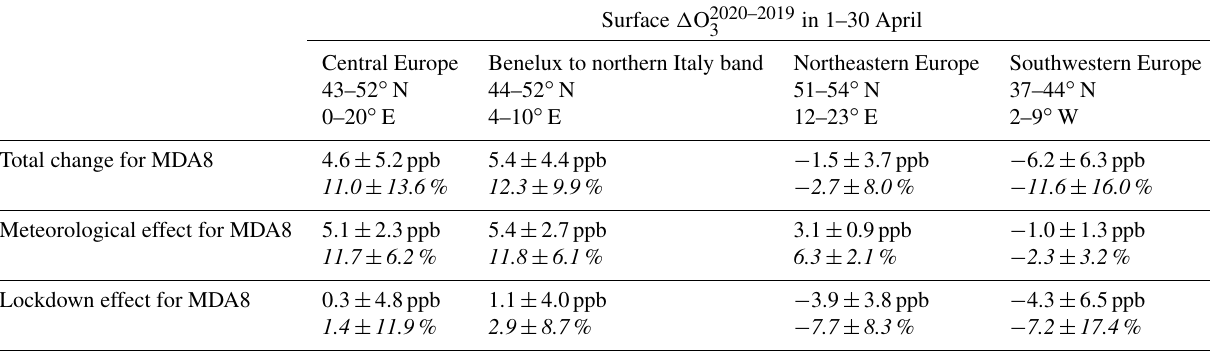
Table 5. Same as Table 4 but for changes of MDA8 surface ozone concentrations averaged over the whole month of April and also percentage in italics.